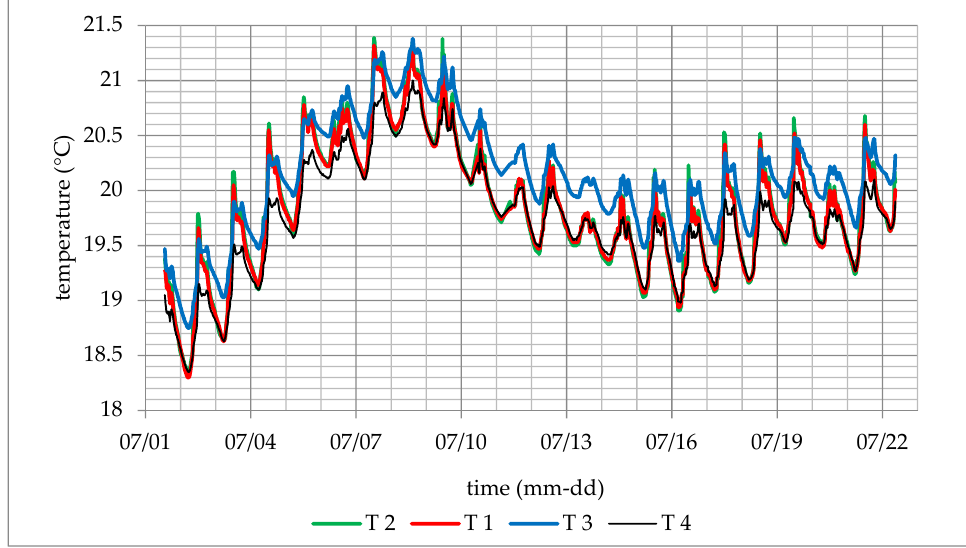
Figure 8. Indoor air temperature, sensors: T1, T2, T3, and T4.